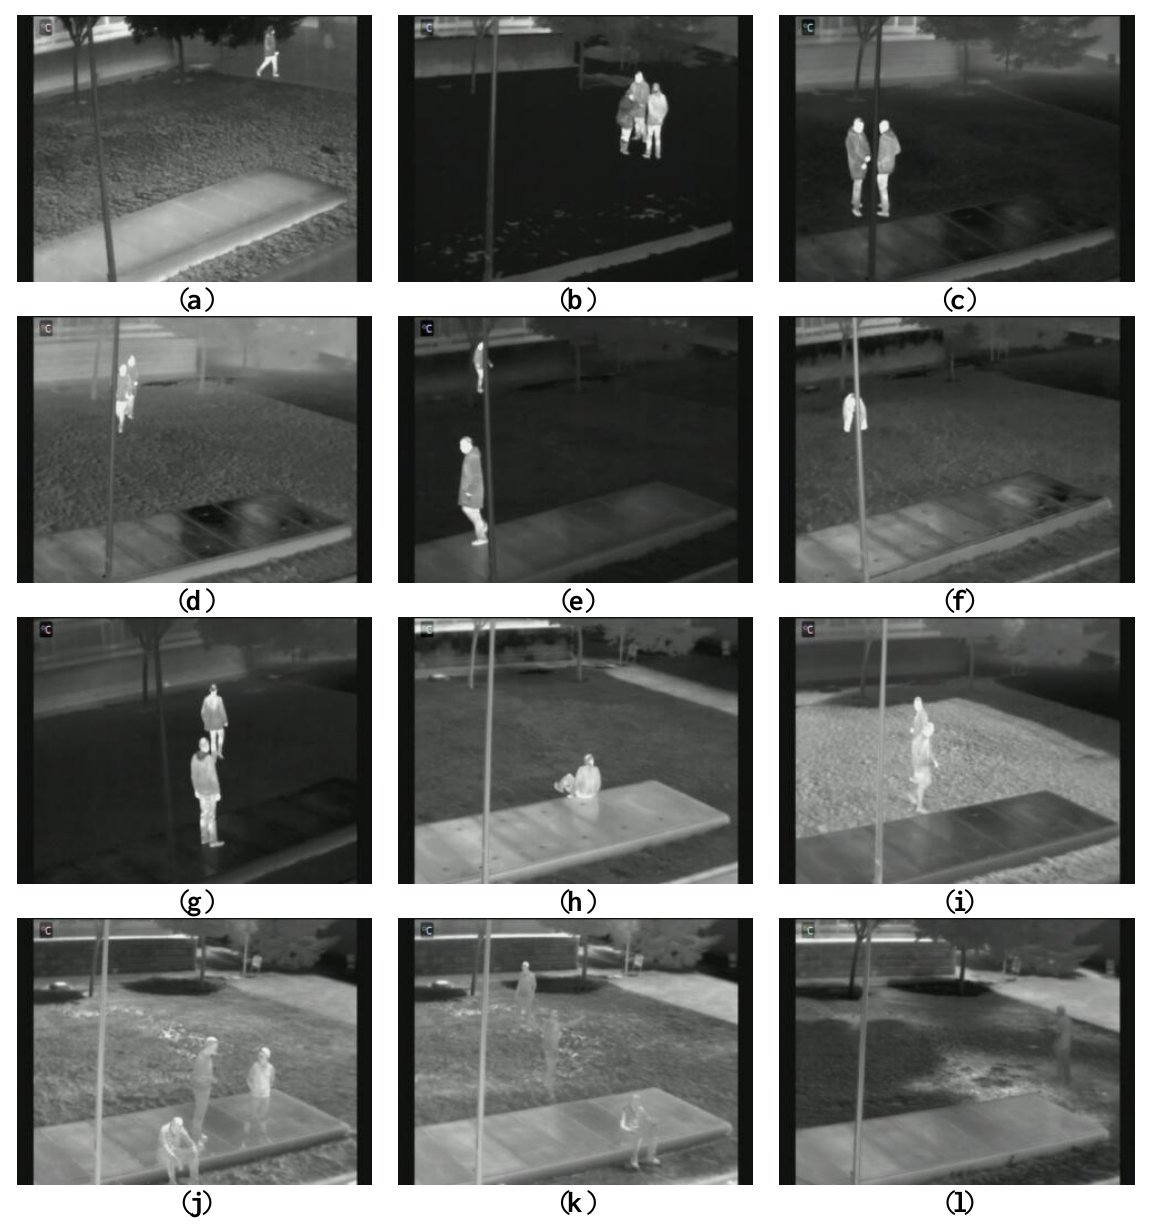
Figure 3. Example frames of the twelve sequences. ( a ) –2° Foggy ; ( b ) 2° Snowy